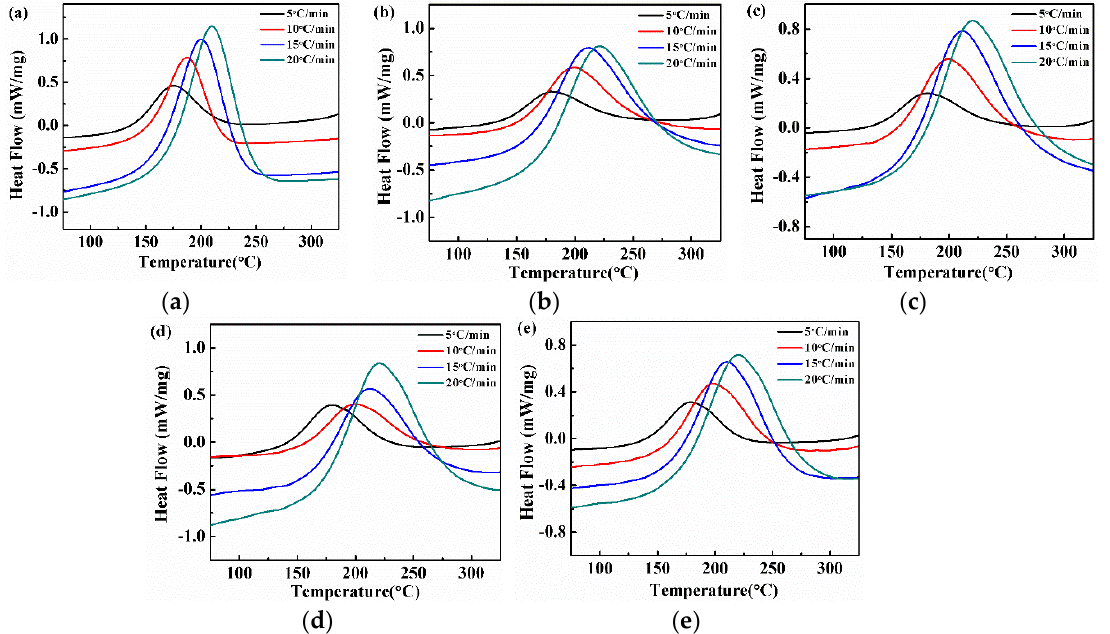
Figure 2. Differential scanning calorimetry (DSC) curves of PSF/epoxy systems at different heating rates of the sample ( a ) 0 phr, ( b ) 5 phr, ( c ) 10 phr, ( d ) 15 phr and ( e ) 20 phr.